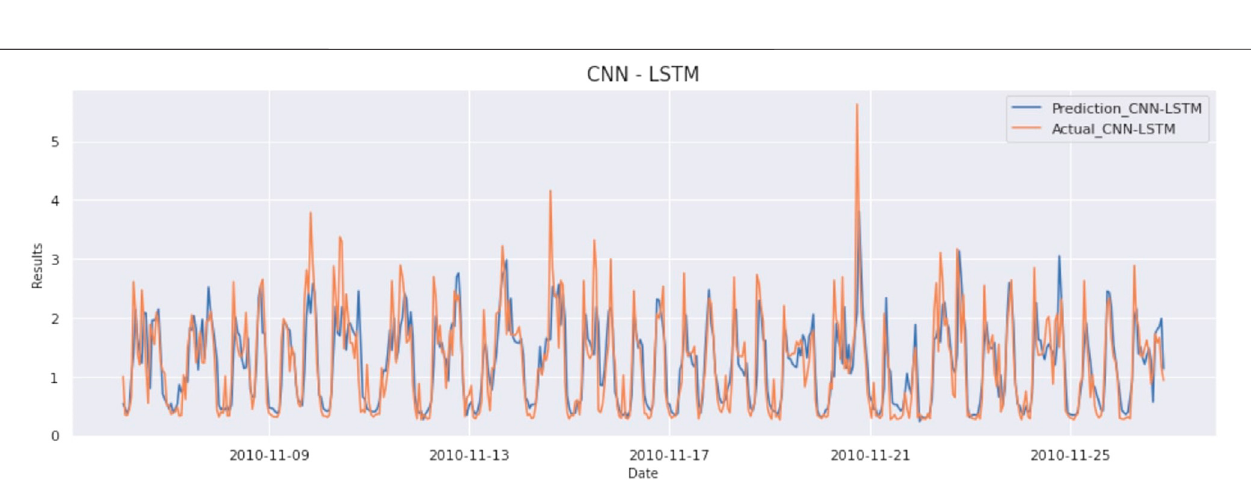
TABLE 1 | Akaike information criterion on HouseHold data (Hebrail and Berard, 2012). Lag order AIC BIC 29 − 5.3868 − 5.0376 30 − 5.3882 − 5.0271 31 − 5.3893 − 5.0161 32 − 5.3892 − 5.0040 AIC, Akaike Information Criterion; BIC, Bayesian Information